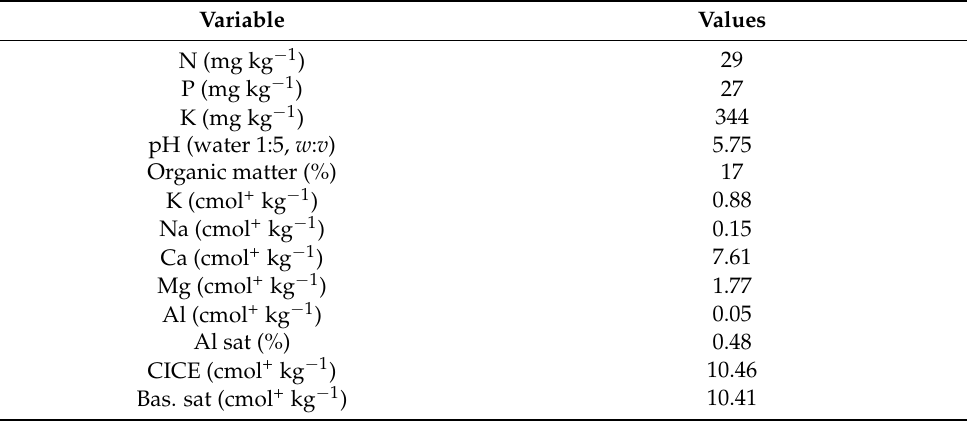
Table 1. The chemical parameters of the Maquehue soil (Freire